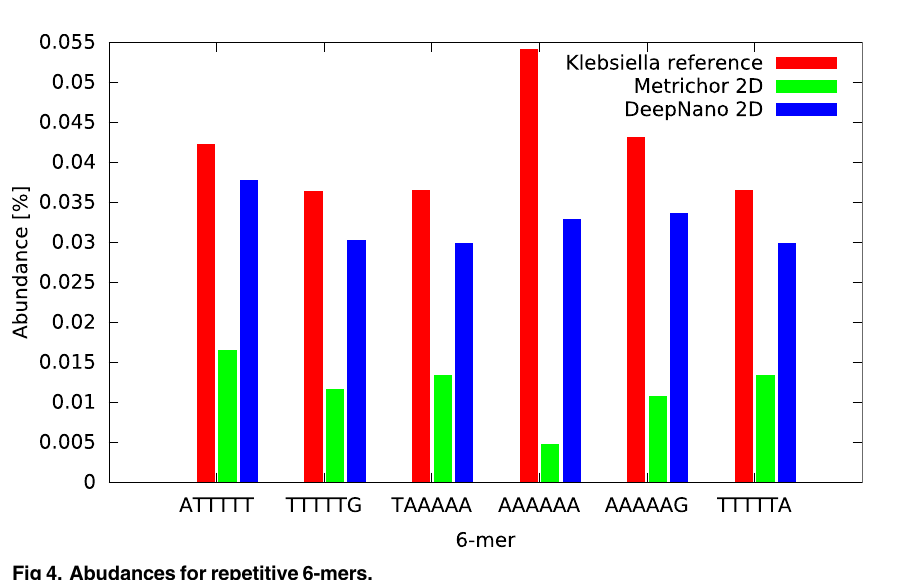
Fig 4. Abudances for repetitive 6-mers.